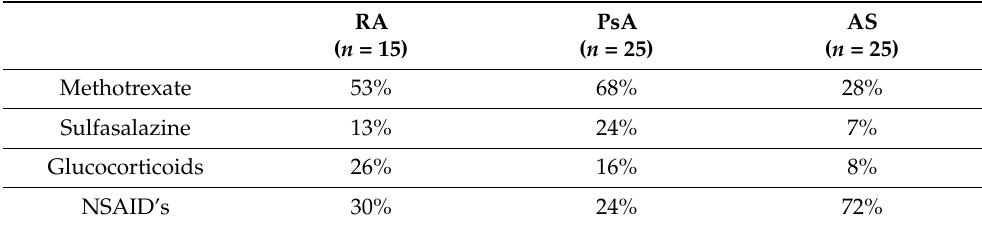
Table 2. Summary of applied